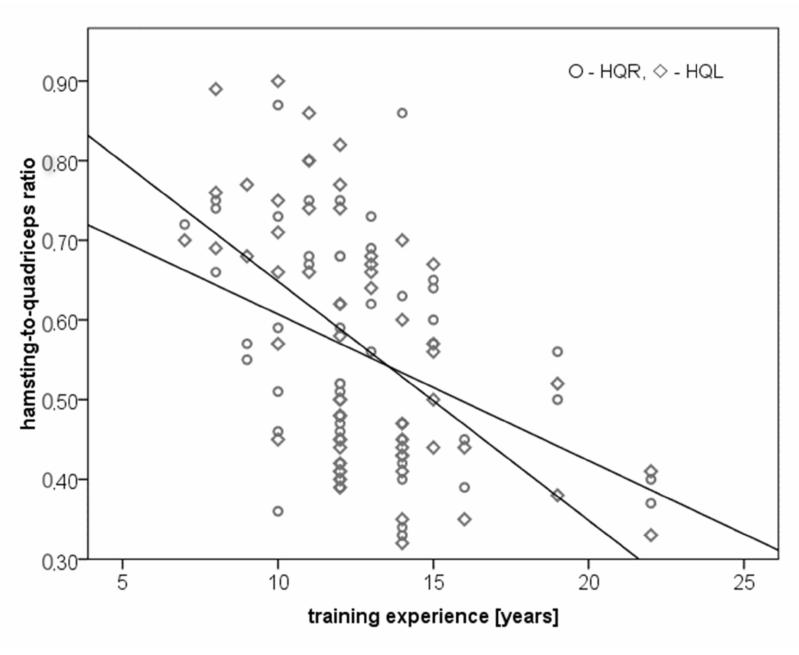
Figure 4. Correlation between hamstring to quadriceps ratio and training experience in